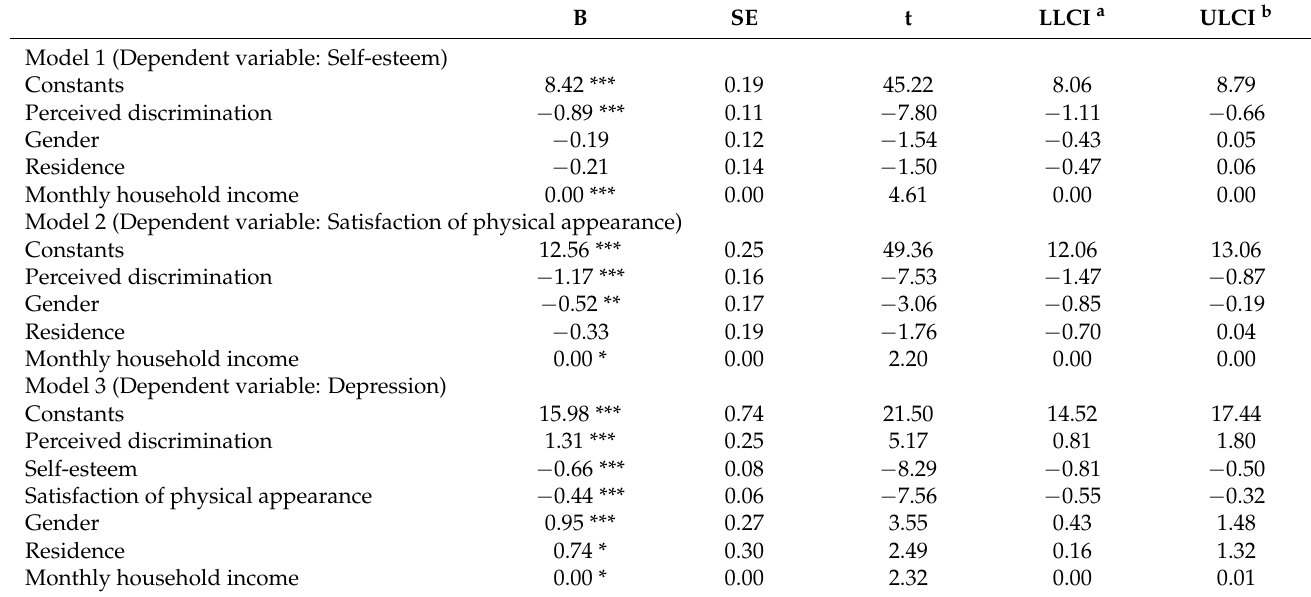
Table 3. Process Macro results.